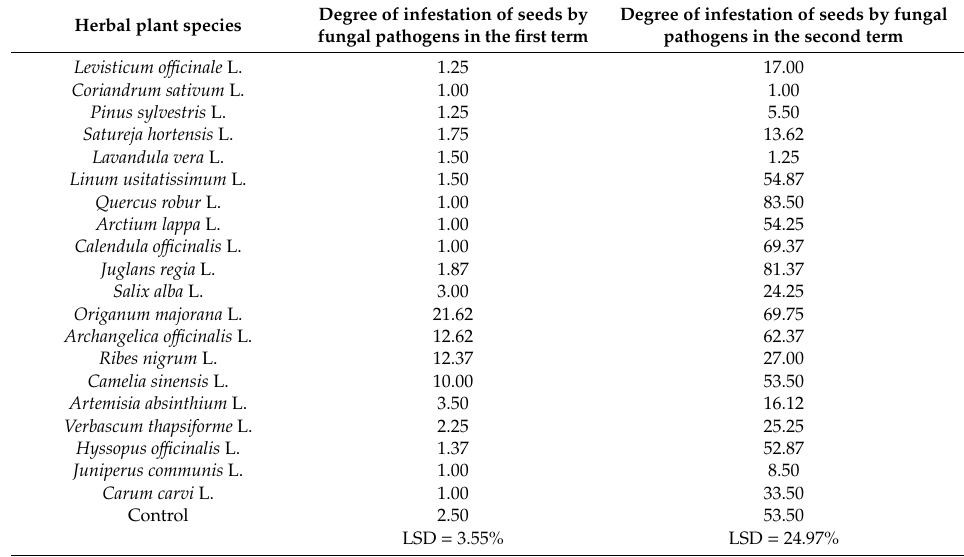
Table 1. Normally sprouted grains (%) depending on the species of plant from which the extracts were obtained and the method of preparation. Herbal plant species Levisticum o ffi cinale L.